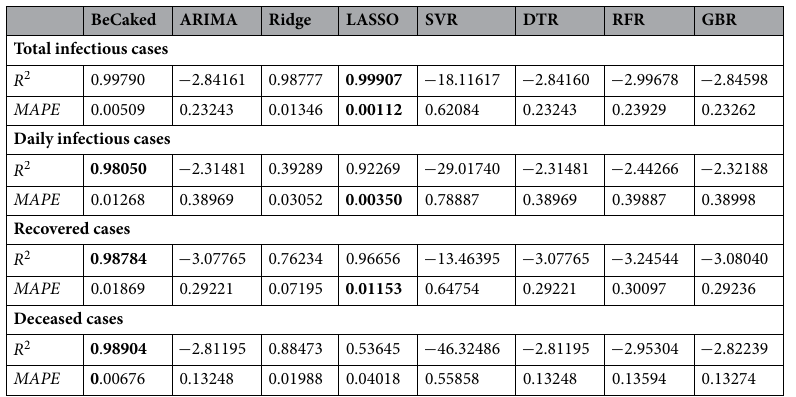
Table 3. Comparison of BeCaked and top-tier forecasting-specialized methods with 31-step forecast. Best results are in [bold].